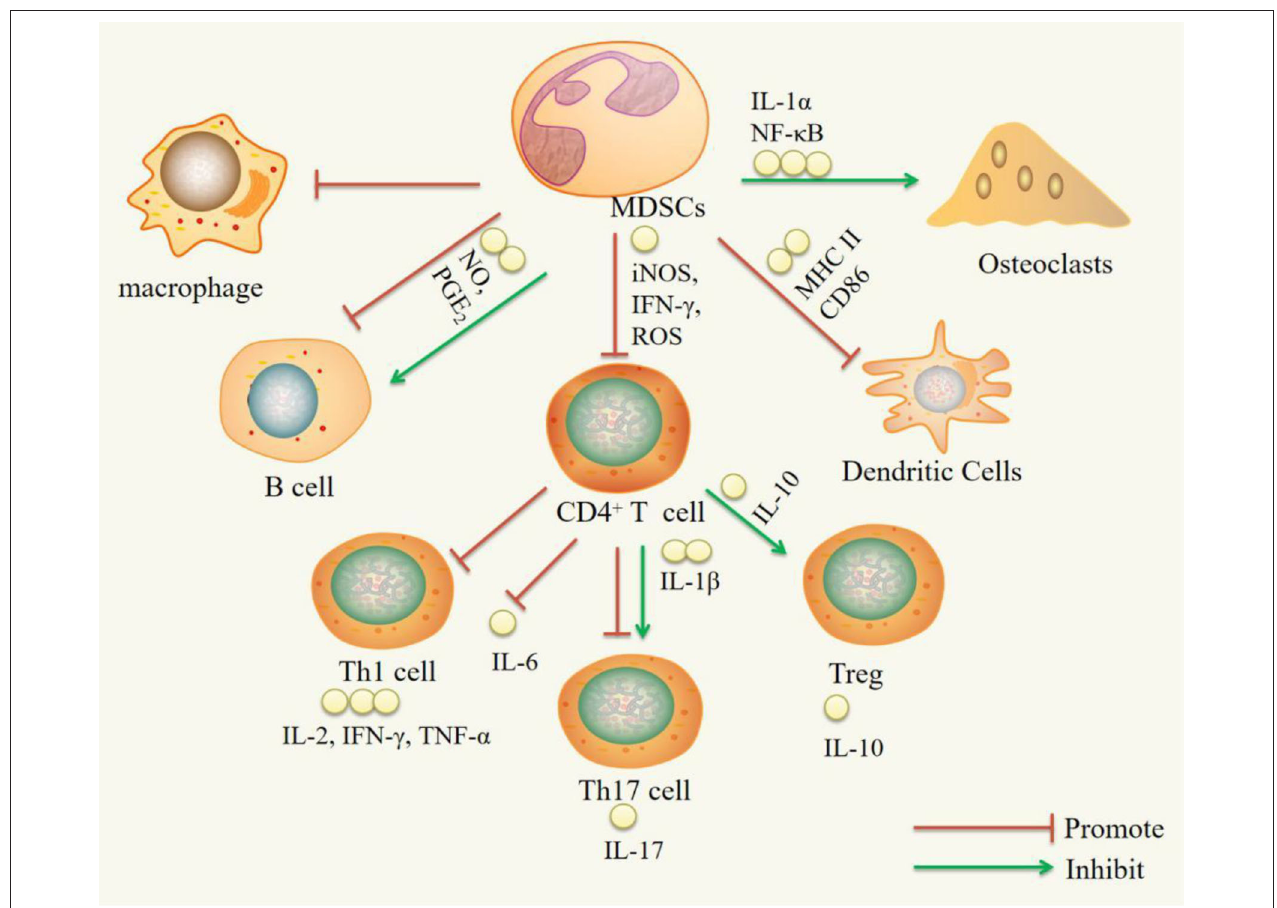
FIGURE 1 | Immuregulatory effect of MDSCs on immune cells. IL-1 α , interleukin-1 α ; NF- κ B, nuclear transcription factor kappa B; iNOS, inducible nitric oxide synthase; IFN- γ , interferon- γ ; ROS, reactive oxygen species; NO, nitric oxide; PGE2, Prostaglandin E2; IL-1 β , Interleukin-1 β ; IL-10, Interleukin-10; IL-2, Interleukin-2; IL-6, Interleukin-6; IL-17, Interleukin-17; TNF- α , Tumor Necrosis Factor- α